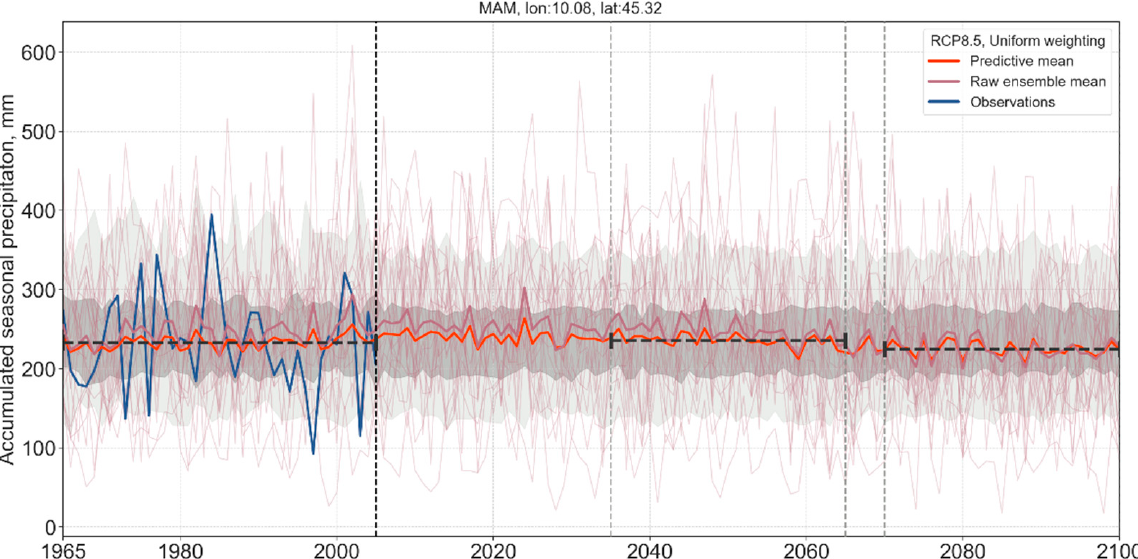
Figure 8. Baseline window and two predictive windows for the prost-processed CMIP5 RCP 8.5 precipitation projections, river Po basin, Northern Italy. The precipitation is given as average over a 1° × 1° reference cell centered in 10.08° E and 45.03° N. Seasonal mean observed precipitation (blue), unprocessed ensemble output (brown), ensemble mean (light red) and post-processed predictive mean (flash red), spring (MAM). The grey-shaded areas indicate the 50% and 95% credible intervals.